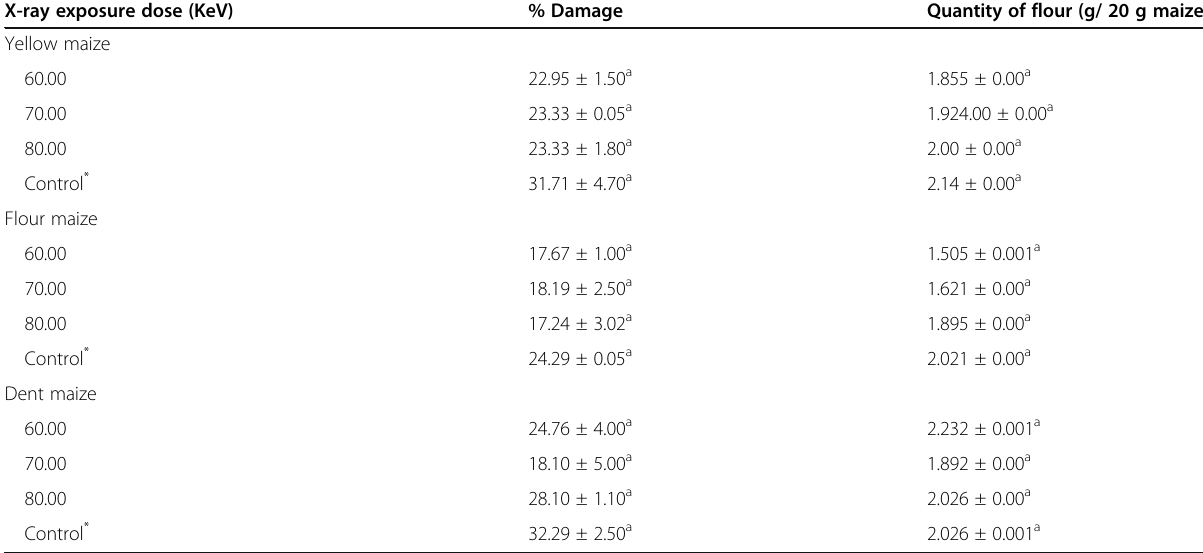
Data are means ± SEM of three replications Mean values in a column with same letter are not significantly different by LSD ( α = 0.05) * Not irradiated with X-ray